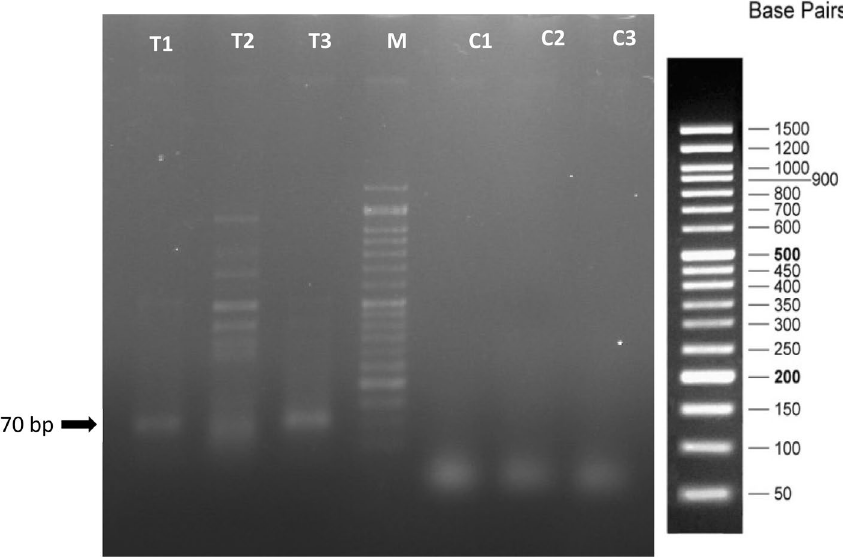
Figure 6. Detection of siRNA in strawberry plants expressing pFGC-TEF-d compare the control plants without pFGC-TEF-d expression. 70 bp shows siRNA detection. T1, T2, and T3 are replications of plants expressing pFGC-TEF-d. C1, C2, and C3 are control plants with no pFGC-TEF-d expression.